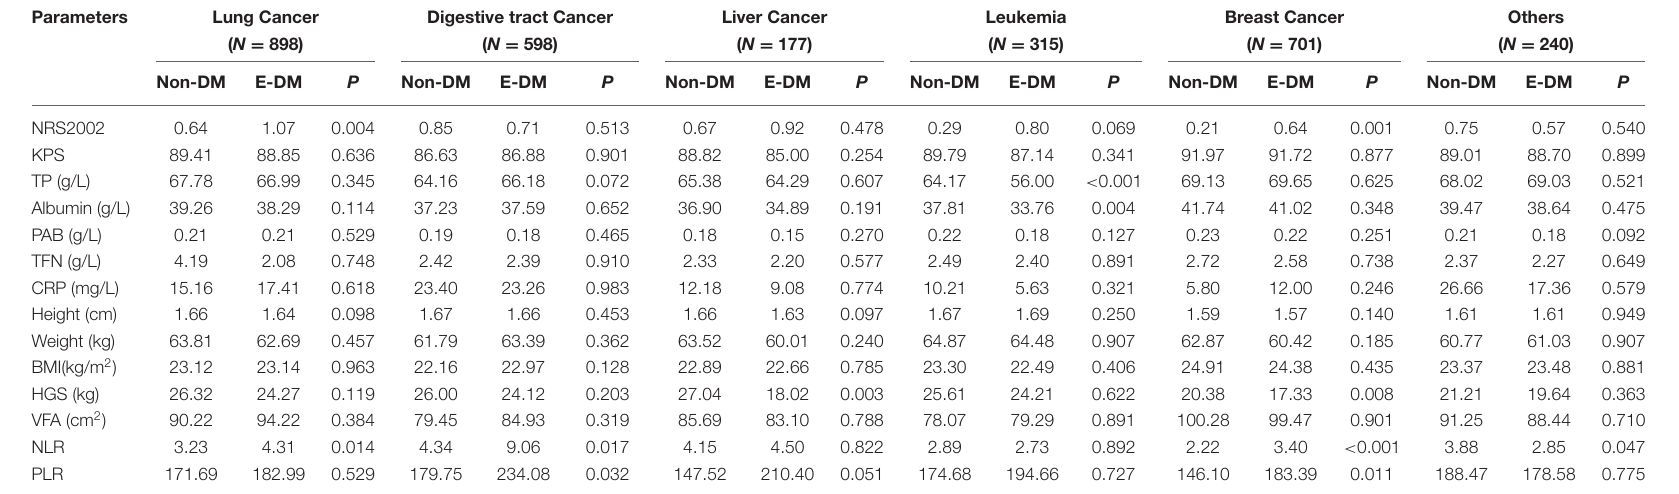
DM, diabetes mellitus; E-DM, euglycemia diabetes mellitus; NRS-2002, the nutritional risk screening-2002 score; KPS, karnofsky performance status; TP, total protein; PAB, prealbumin; TFN, transferrin; CRP, C-reaction protein; BMI, body mass index; NLR, neutrophil to lymphocyte ratio; PLR, platelets to lymphocyte ratio; HGS, hand-grip strength; VFA: visceral fat